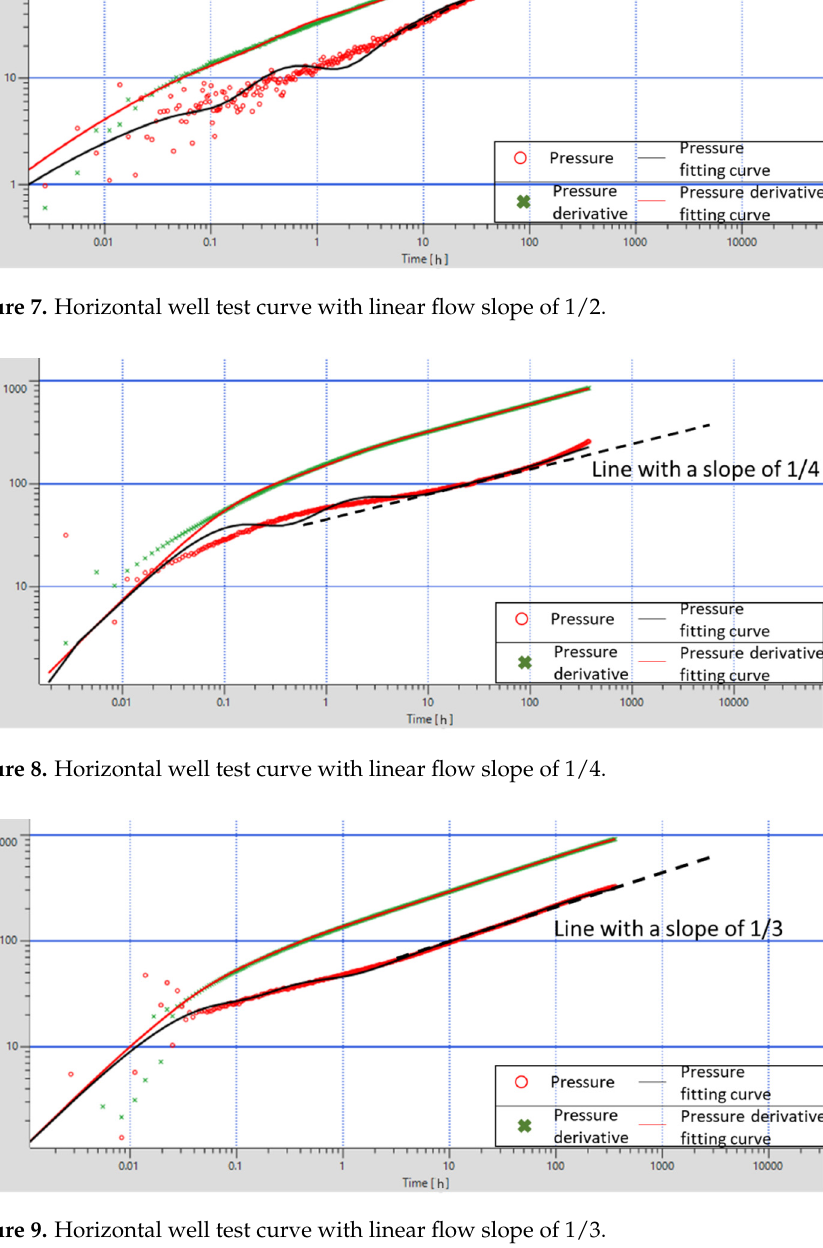
Figure 9. Horizontal well test curve with linear flow slope of 1/3.